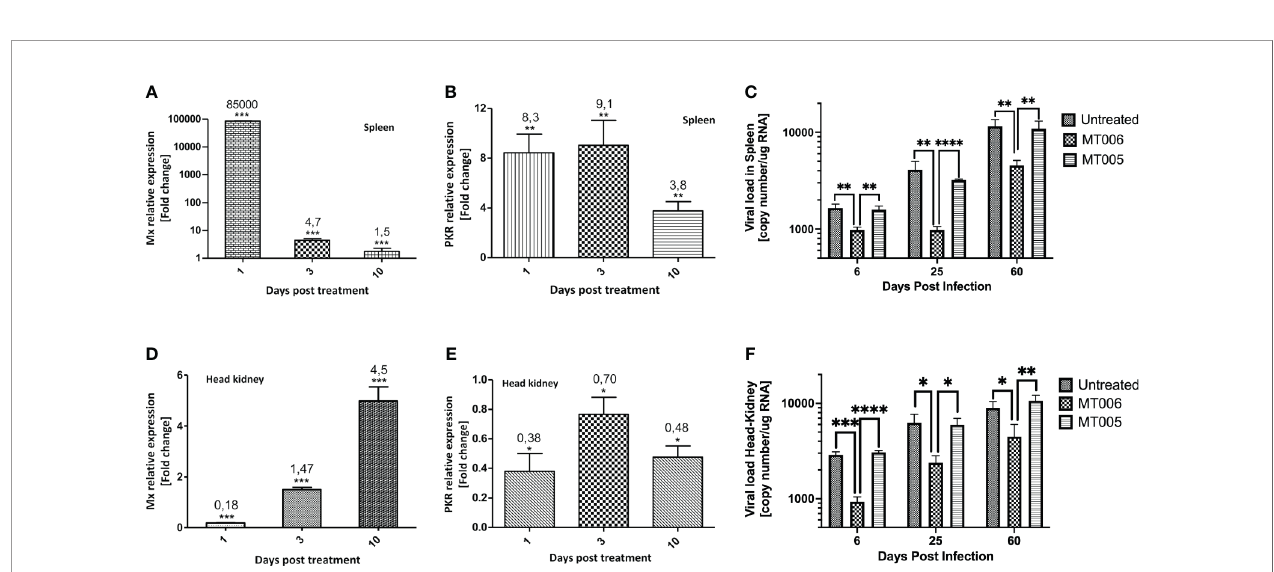
FIGURE 4 | In vivo effect of the administration of MT006. The fi gure shows the effect of the administration of MT006 for 5 days [10 7 CFU/( fi sh * day)] on the gene expression of Mx (A, D) and PKR (B, E) in spleen (A, B) and head kidney (D, E) . The effect on expression is shown as fold changes normalized to the expression of the gene encoding for 18S rRNA, and on expression in fi sh fed L. lactis NZ3900 containing plasmid pNZ8149 (MT005). The fi gure also shows the effect of MT006 administration on viral load in fi sh infected intraperitoneally with IPNV (C, F) . Viral load was normalized by the amount of RNA used in the RT-qPCR assay. The statistical analyzed was performed using a parametric t-test *p < 0.05, **p < 0.01, ***p < 0.001, ****p < 0.0001.